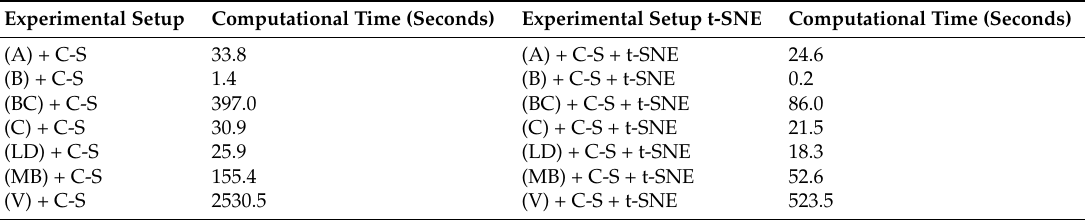
Figure 2. Accuracy results for standard classifiers tested in seven UCI public datasets. The databases correspond to A: audiology, B: balloons , BC: breast cancer, C: Chess, LD: Lymphography Domain, MB: Molecular Biology, V: Congressional Voting Records. The subfigures ( a ), ( b ), ( c ), ( d ) illustrate the outcomes for LDC, QDC, K-nn, and SVM, respectively. The colors detailed in the legend of subfigure ( e ) refer to each experimental setup. Table 4. Computational times for standard classifiers tested in seven UCI public datasets. The datasets: A, B, BC, C, LD, MB, V are described in Table